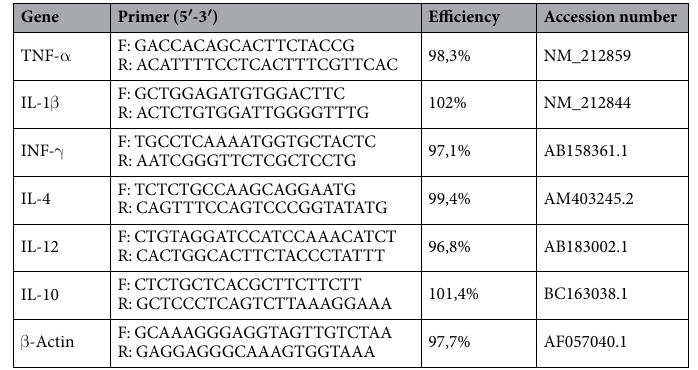
Table 1. Immune genes, primers nucleotide sequence and qPCR